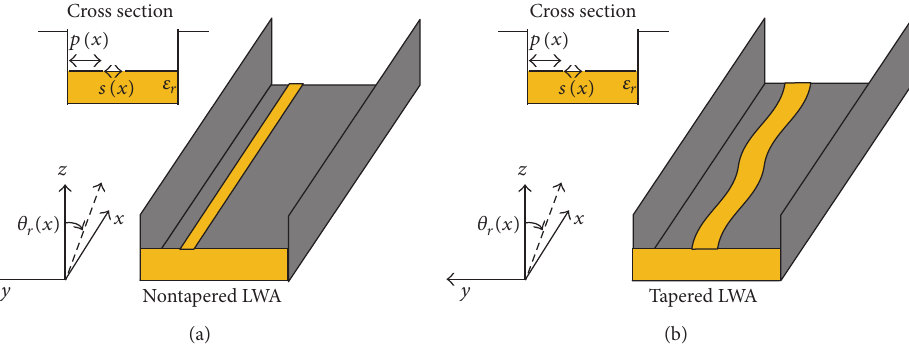
Figure 6: Leaky-wave antenna in hybrid waveguide printed-slot-circuit technology: (a) nontapered LW antenna radiating a far-field focused field; (b) a near-field focused LW antenna based on a tapered printed slot [61].